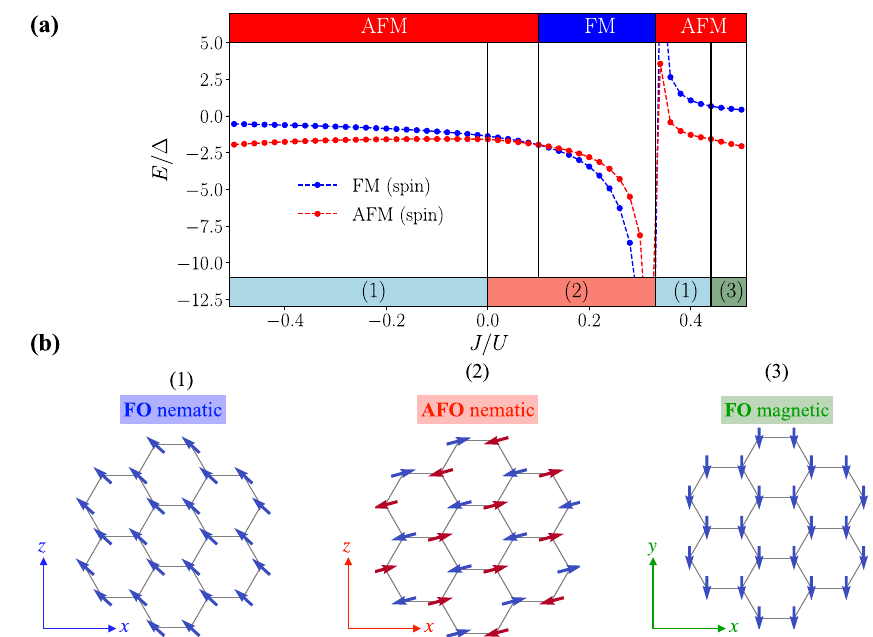
Fig. 4 Magnetic phase diagram for twisted bilayer MoS 2 . a Classical ground state energy per orbital in units of Δ ¼ t 2 σ = U , assuming ferro- (blue) or antiferromagnetic (red) order for the spin degrees of freedom. We take the ab initio parameters, t π = 0.25 t σ and use an iterative energy minimization. The lower panel determines the phase boundaries for the orbital degrees of freedom given the energetically more favorable spin order shown in the top panel. At J / U = 0.1 we fi nd the spin order to change from AFM to FM, with AFO nematic order for the orbital degrees of freedom remaining stable in agreement with ref. 53 . b Con fi gurations of orbital vectors are found at the end of iterative minimization. Note that we display the projection of τ to the plane in R 3 (indicated by the axis shown in the bottom left), such that nematic states with fi nite contributions only in xz direction ((1) & (2)) can be distinguished from magnetic states (3) which point perpendicular, i.e along the y